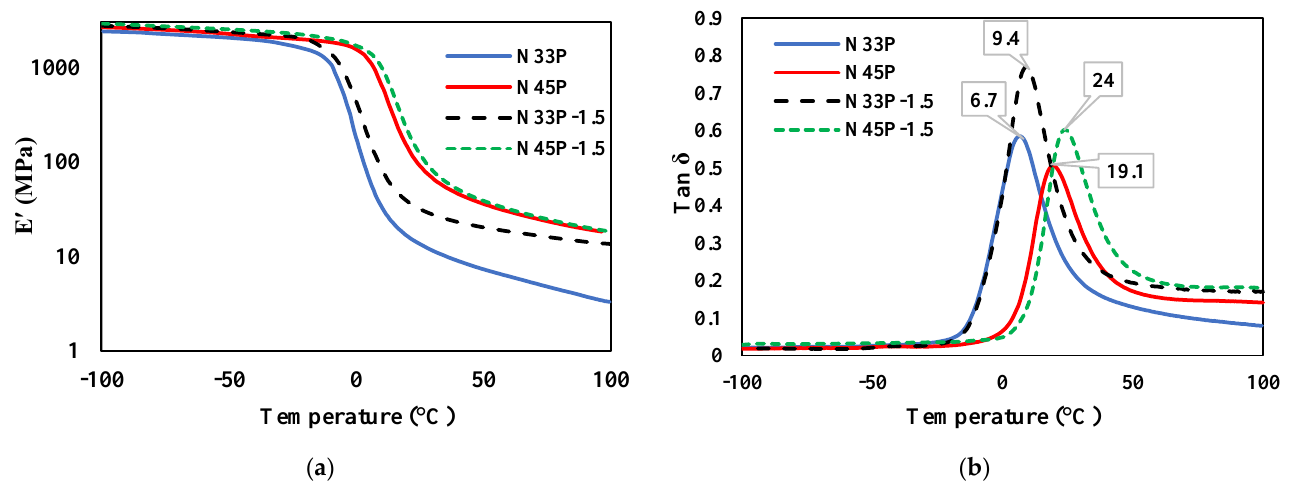
Figure 8. DMTA analysis results of the samples from − 100 to 100 °C, at a frequency of 1, in an air environment; the heating rate was 5 °C/min; ( a ) storage modulus; ( b ) loss factor.